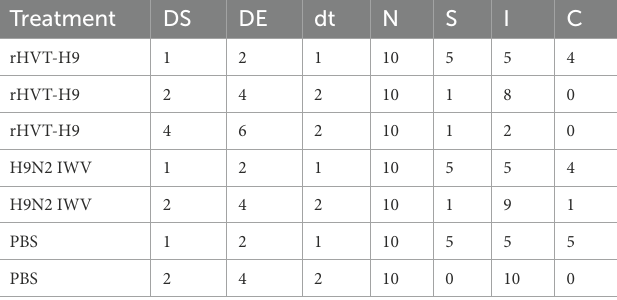
TABLE 4 Data abstracted from the transmission experiment for parameter estimation for the stochastic transmission model.